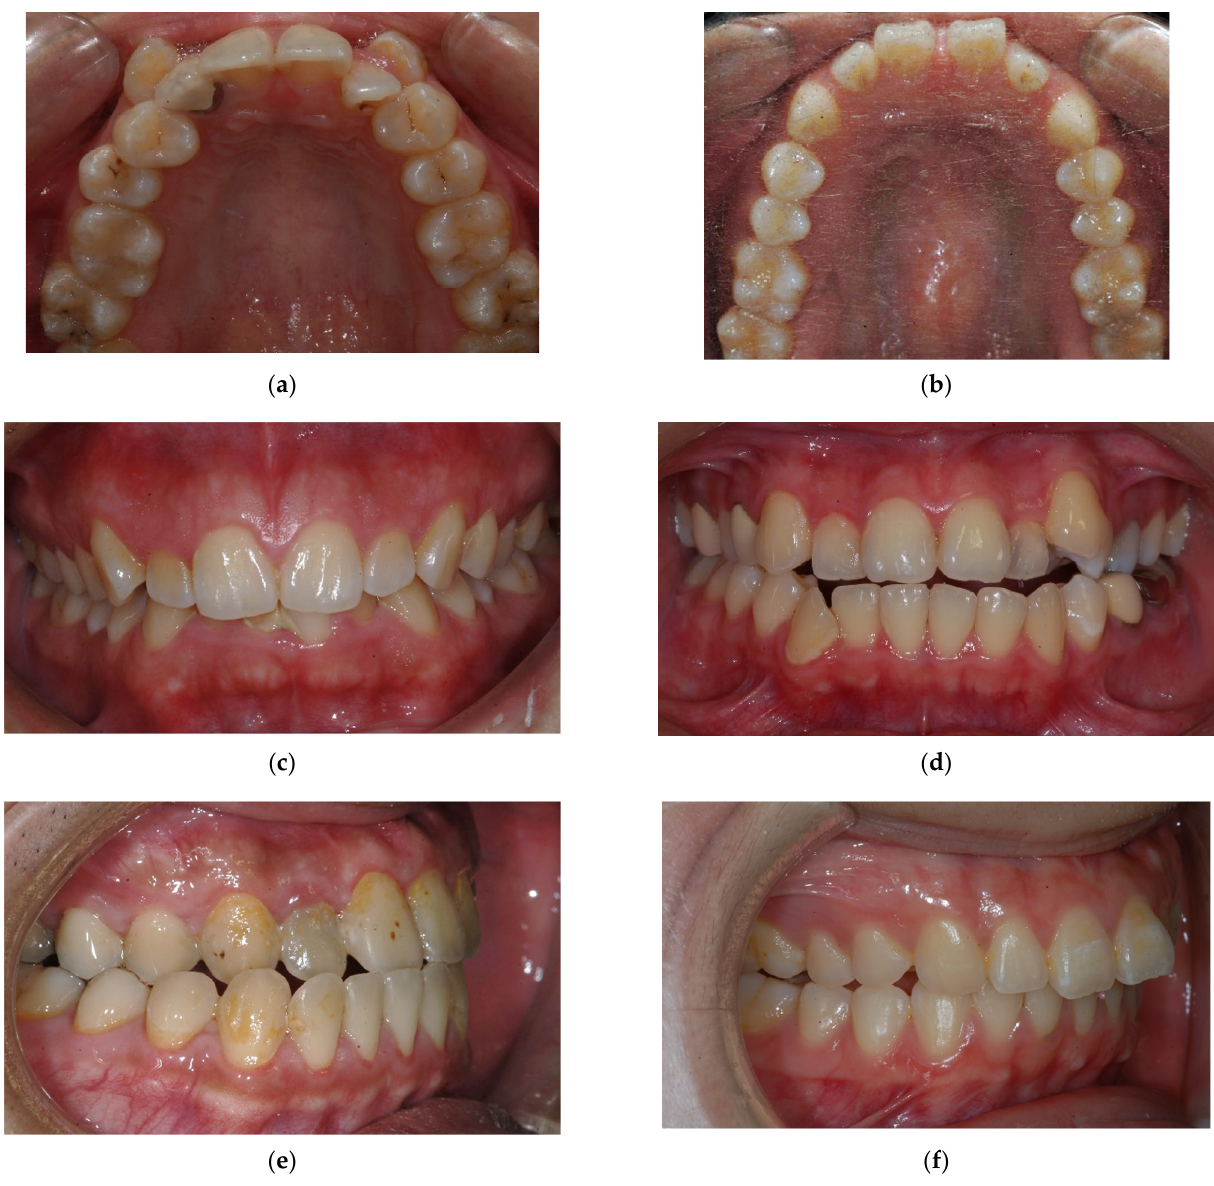
Figure 8. ( a , b ) Upper arch crowding/spacing: ( a ) Crowding indicates that there is a discrepancy between the space required by the teeth and the space available. ( b ) Spacing: the opposite of crowding, the space available exceeds the space needed. ( c , d ) Incisor overbite: Incisor overbite indicates the anterior vertical relationship. ( c ) Deep bite: there is a vertical overlap of the incisors. ( d ) Open bite: there is no vertical overlap of the incisors. ( e ) Crossbite: Crossbite indicates the transverse relationship. Normally, the buccal cusp of the mandibular dentition should occlude to the lingual cusp of the maxillary dentition. ( f ) Buccal segment anteroposterior relationship: The anteroposterior cuspal relationship of premolars and molars. Normally, it should be a cusp-to-embrasure